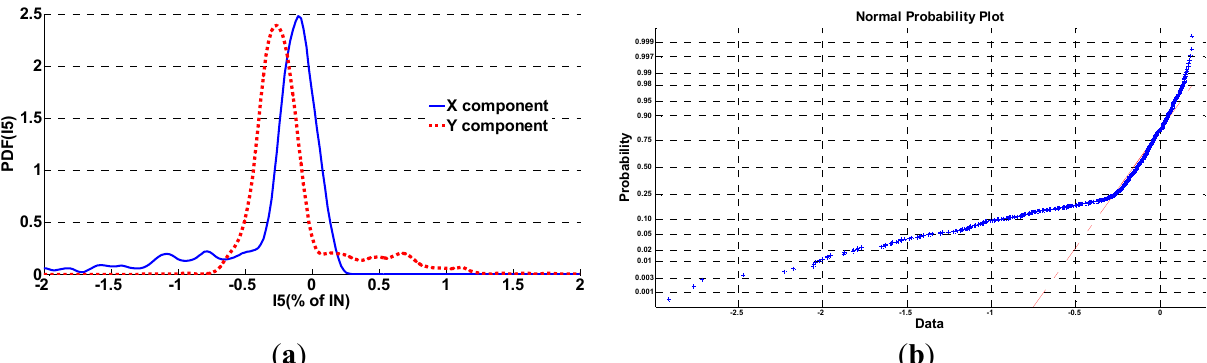
Figure 12. Pdfs of the fifth harmonic current and Normal verification. ( a ) Pdfs of X and Y components; ( b ) The Normal probability verification plot.